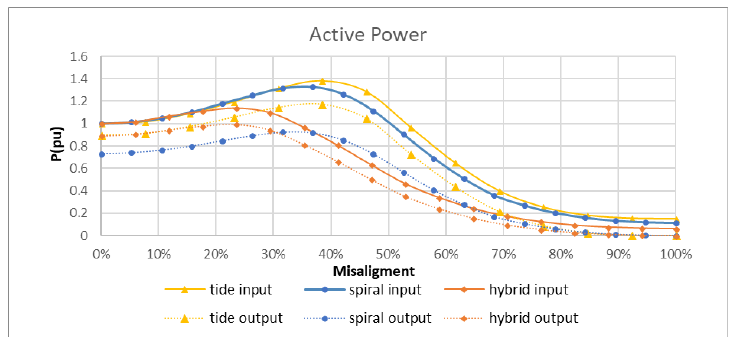
Figure 26. Measured active power for primary compensation with resistive load.